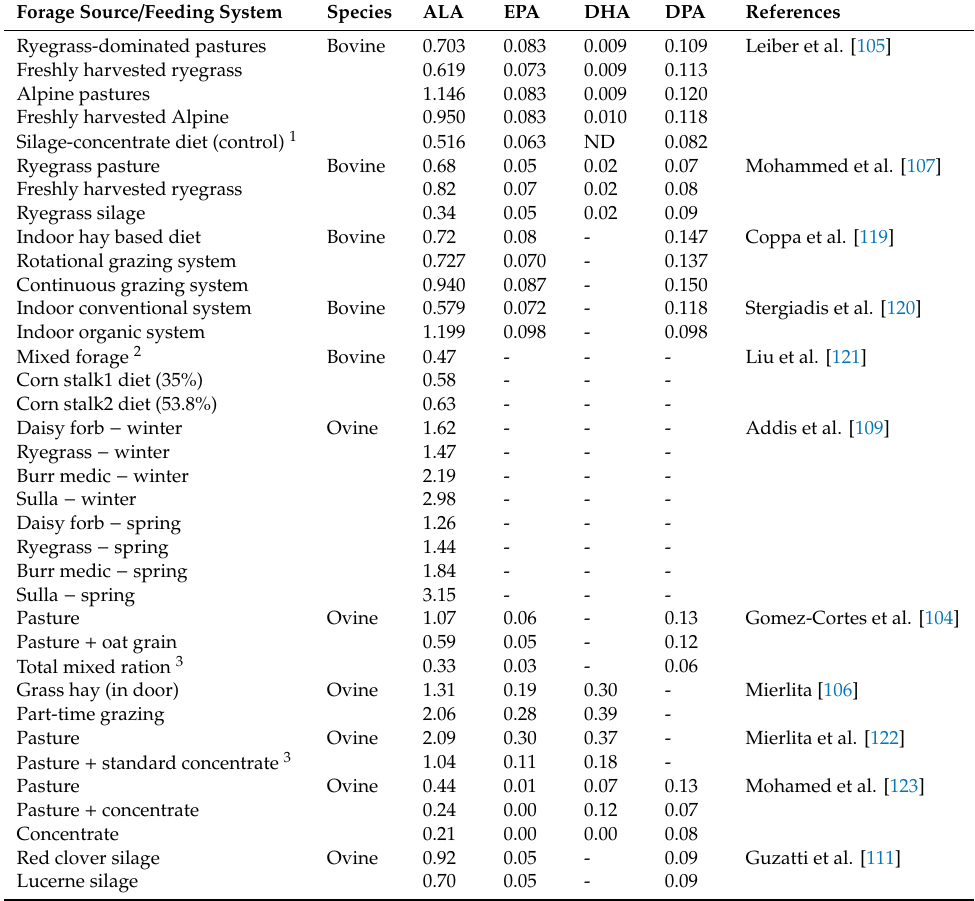
Table 3. E ff ect of pasture feeding regimes on n-3 PUFA content of milk (g / 100 g fatty acids). Forage Source / Feeding System